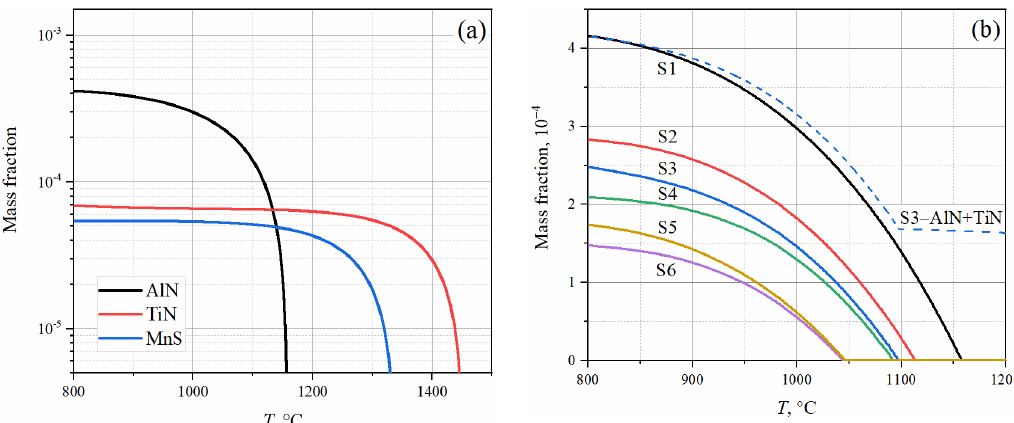
Figure 5. ( a ) Calculated equilibrium precipitation in S1; ( b ) equilibrium mass fractions of AlN in different steels.